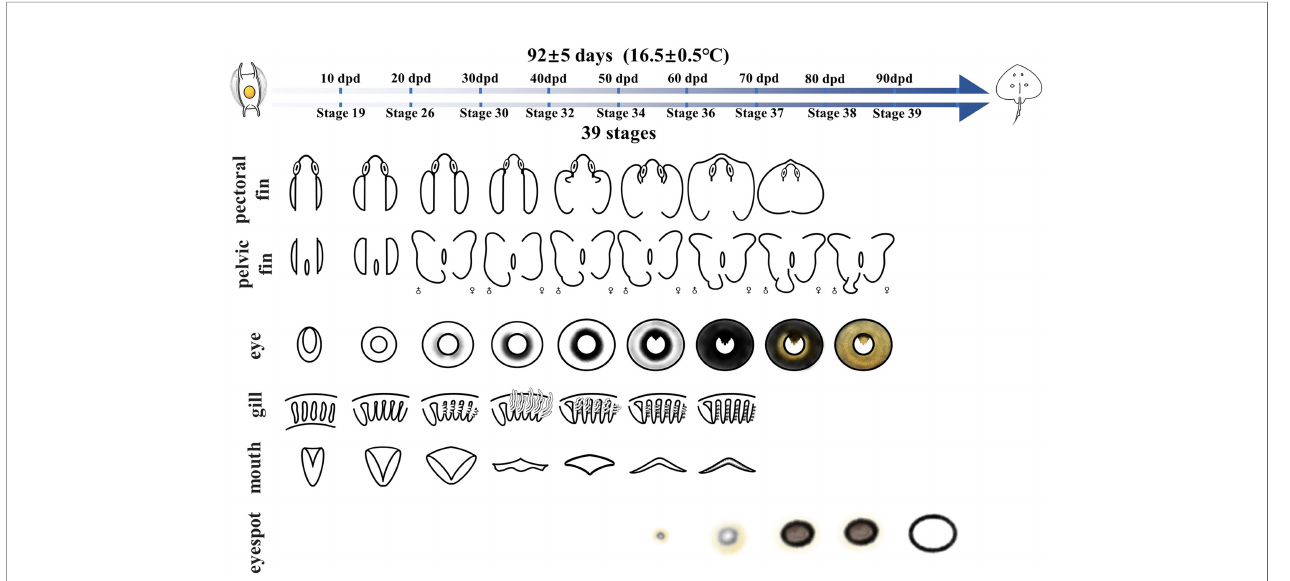
FIGURE 7 | Developmental phases of the Kong skate, O. kenojei , within 92 ± 5